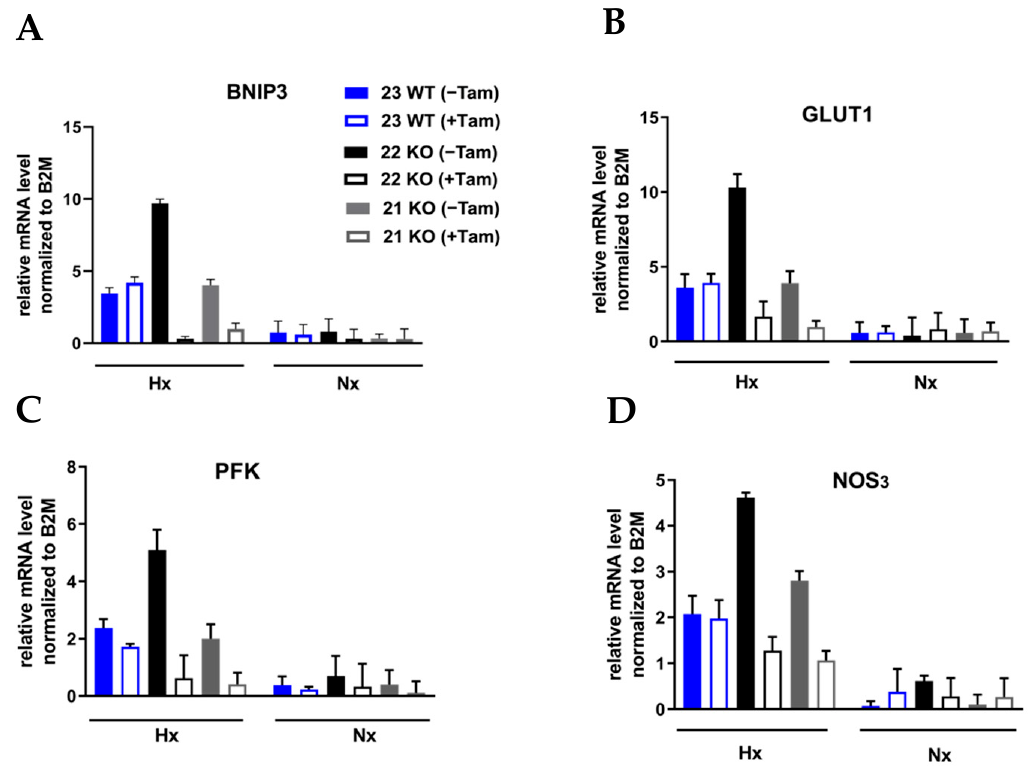
Figure 4. Analysis of mRNA levels of HIF-1 α target genes in mHDC by RT-qPCR. The cells were grown overnight in normoxia (NX) or hypoxia (HX, 1% O 2 ). The cDNA levels of the target genes ( A ) BNIP3, ( B )GLUT-1, ( C ) PFK, and ( D ) NOS3 were analyzed by qPCR and normalized to the cDNA levels of the control gene ß2-microglobulin (B2M).